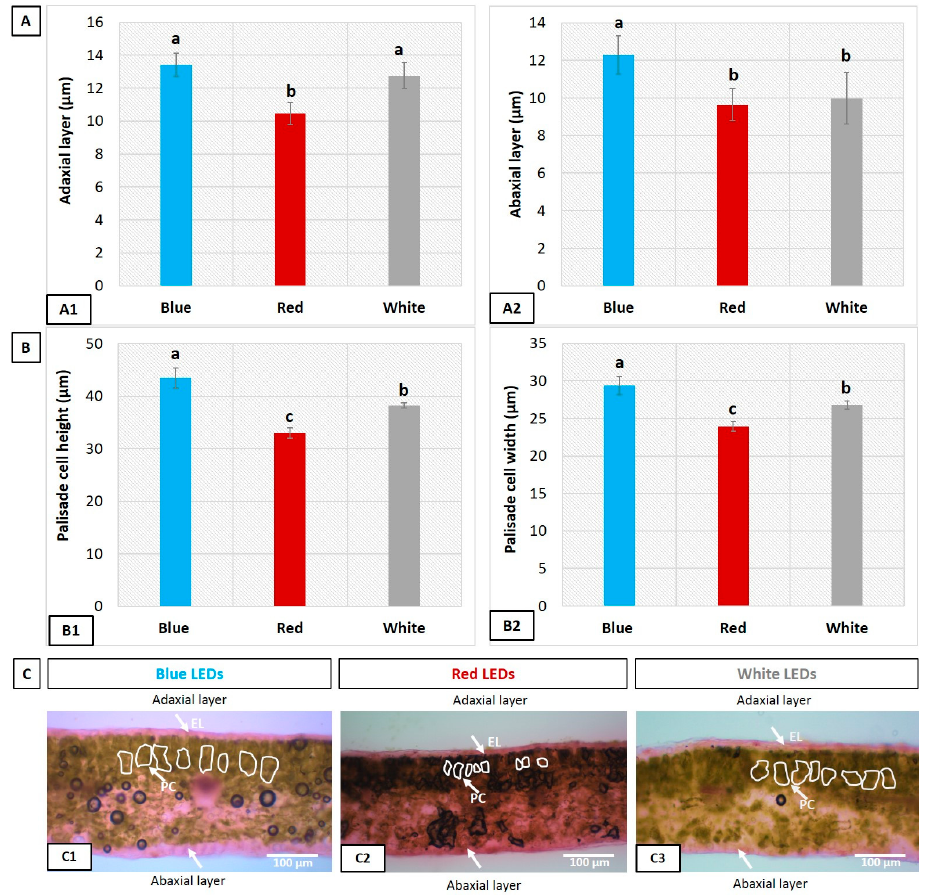
Figure 4. Effect of blue, red, and white LEDs on the leaf anatomy of Eustoma : ( A1 ), adaxial layer ( µ m) and ( A2 ), abaxial layer ( µ m); ( B1 ), palisade cell height ( µ m) and ( B2 ), palisade cell width ( µ m). Representative cross-sections showing anatomical parameters of the adaxial and abaxial epidermal layers in Eustoma leaves under B, R, and W LEDs: ( C1 ), blue (B); ( C2 ), red (R), and ( C3 ), white (W) LEDs. Data are mean values ( n = 10) and the vertical bars represent ± SE (Tukey’s HSD at P < 0.05).